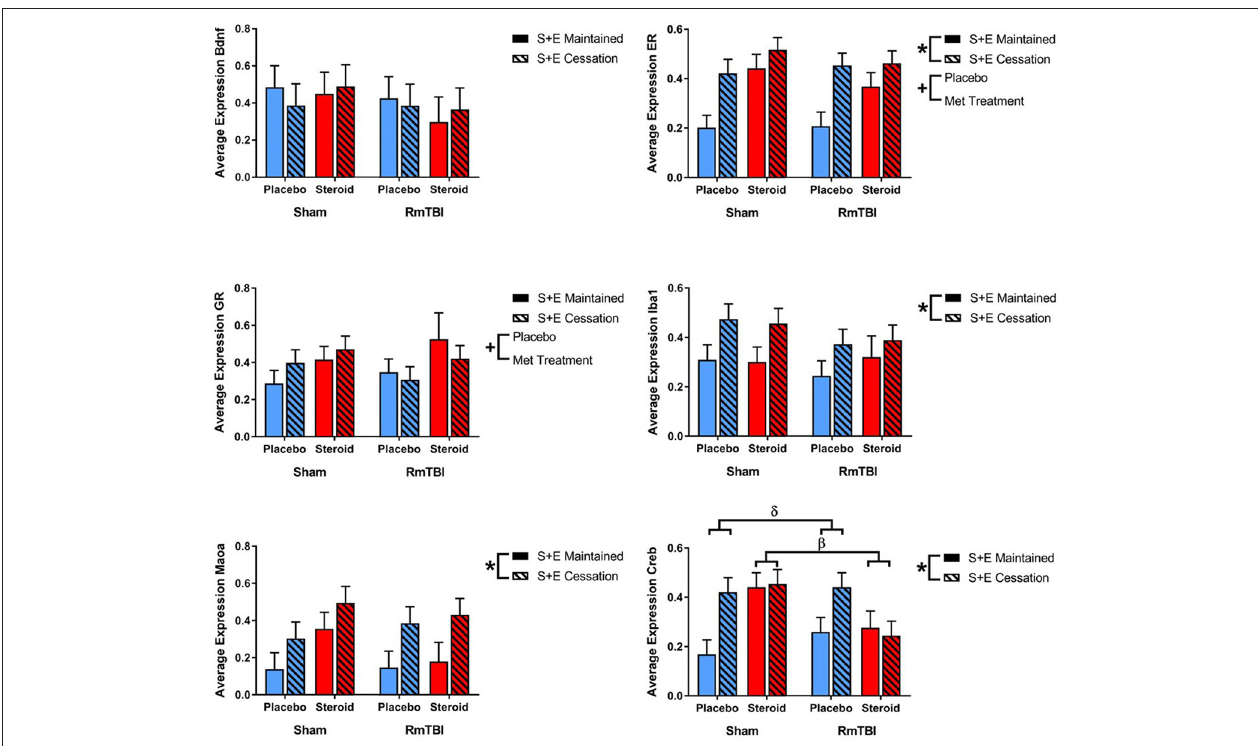
FIGURE 5 | Bar graphs displaying average mRNA expression levels in the PIT. Means ± standard error are displayed where *main effect for SEC, + main effect of Met treatment, β significant Met treatment by RmTBI interaction, and δ significant Met treatment by SEC interaction p ≤ 0.05. Post-hoc analysis of Creb demonstrated that the Met Treatment by Injury interaction was driven by animals in the Steroid group. Rats with sham injuries in the steroid group exhibited greater expression of Creb than rats with RmTBI in the steroid group, p < 0.01. The second post-hoc analysis found that the Met Treatment by SEC interaction was driven by the placebo group, whereby cessation of AAS and exercise significantly increased expression of Creb in animals that did not receive AAS, p < 0.01. mRNA, messenger RNA; PIT, pituitary; RmTBI, repetitive mild traumatic brain injury; S + E, steroid and